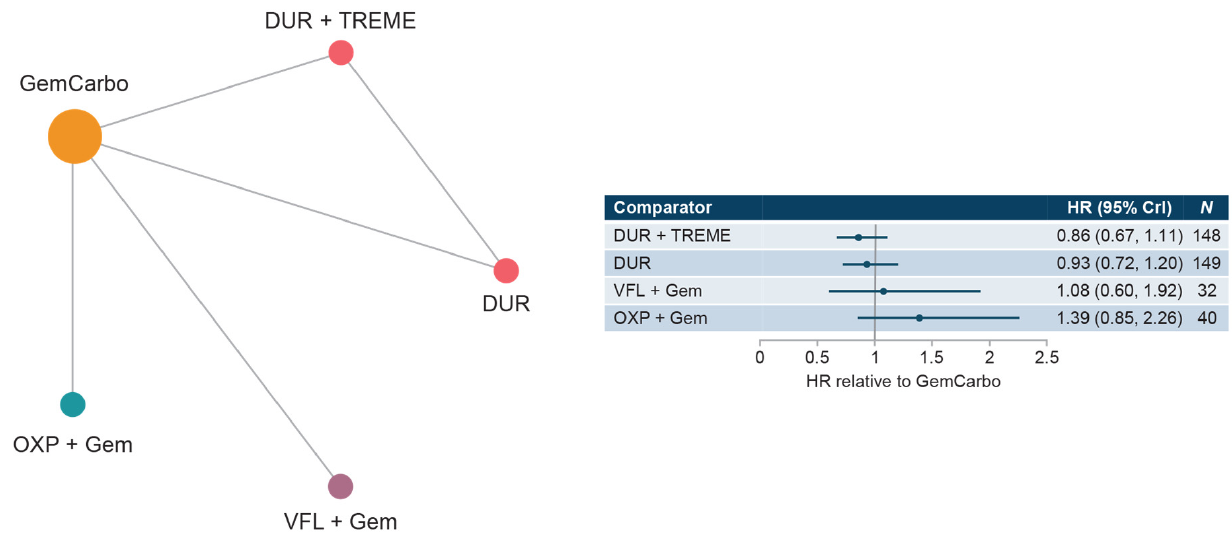
Figure 3. Network diagram and HR for OS by treatment network for the cis-ineligible (strict) network. Abbreviations: Cis, cisplatin; CrI, credible interval; DUR, durvalumab; Gem, gemcitabine; GemCarbo, gemcitabine + carboplatin; HR, hazard ratio; OXP, oxaliplatin; OS, overall survival; TREME, tremelimumab; VFL, vinflunine.